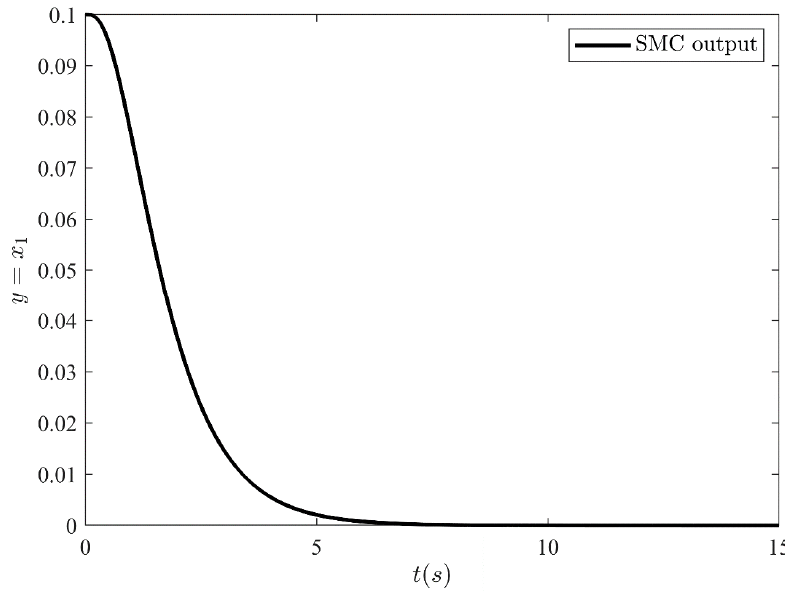
Figure 4. SMC output under full state feedback control.